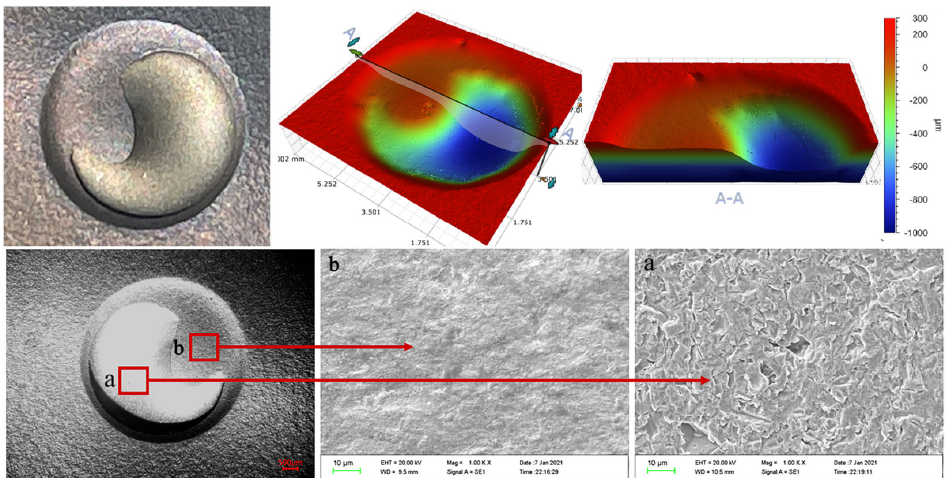
Figure 5. Cross ‐ sectional SEM micrgraph of the coating after different pretreatment processes. (a) Coating after polishing pretreatment. (Figure ① is a partial enlarged view of the red box in Figure a) (b) Coating after grit blasting pretreatment. (Figure ② is a partial enlarged view of the red box in Figure b) (c) Coating after laser ablation texture pretreatment. (Figure ③ is a partial enlarged view of the red box in Figure c)